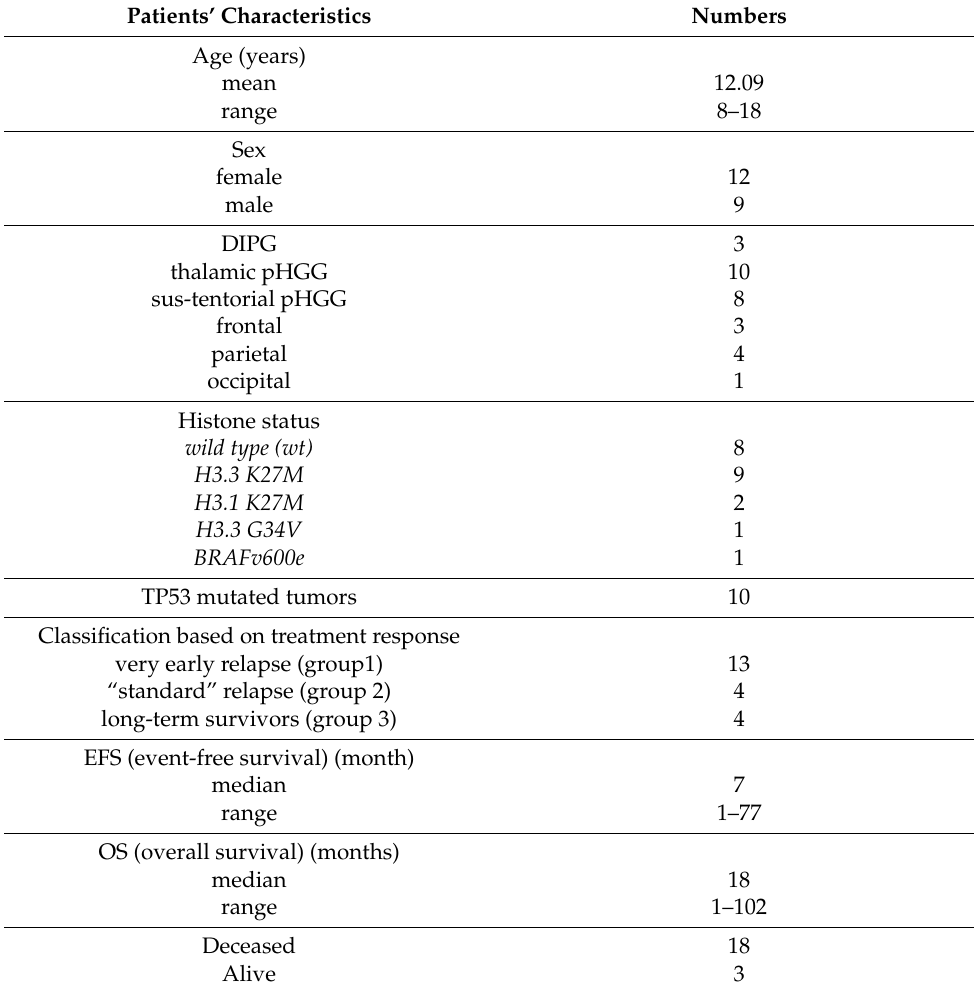
Table 1. Patients’ clinical and theranostic